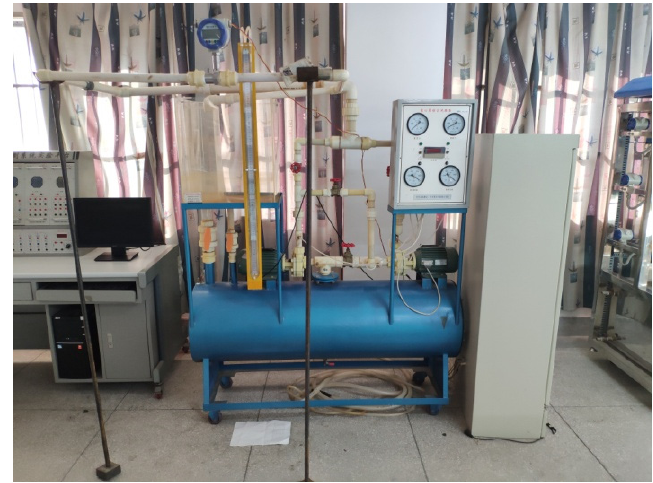
Figure 8. Centrifugal pump comprehensive test device.